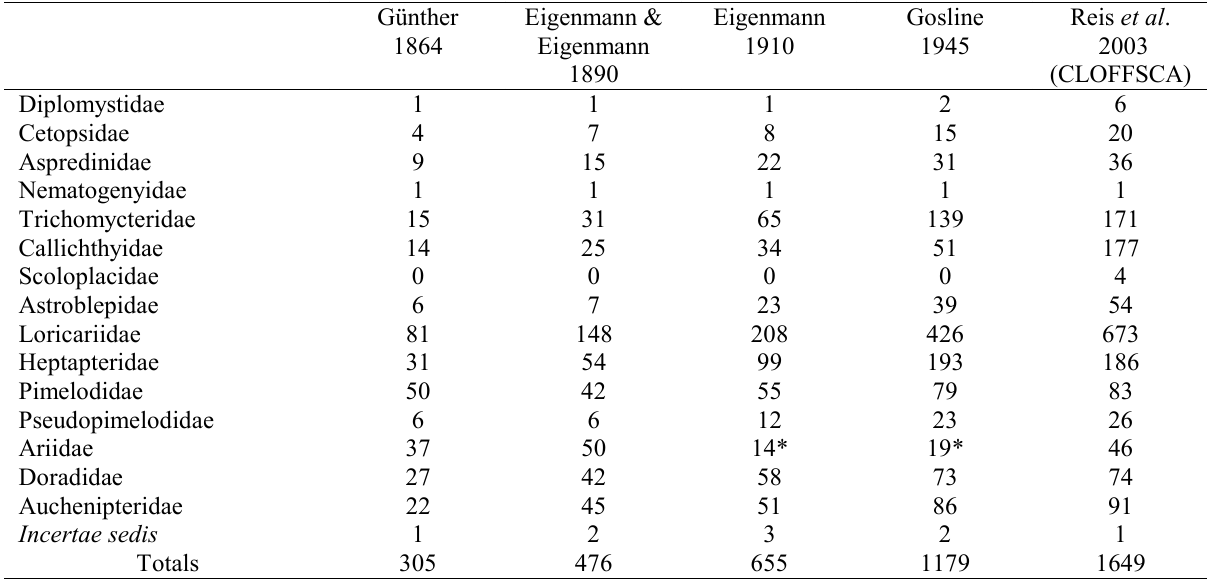
Table 1. Number of species of Neotropical catfishes, by family, listed in published compilations from 1864 to 2003. Family assignments of species and order of presentation of families follow CLOFFSCA, with a separate category of incertae sedis for species of the currently-unplaced genus Conorhynchos . As in CLOFFSCA, taxa listed as valid subspecies were counted separately in the relevant tallies. Counts followed by an asterisk indicate that the tally only included freshwater species, excluding both marine and estuarine